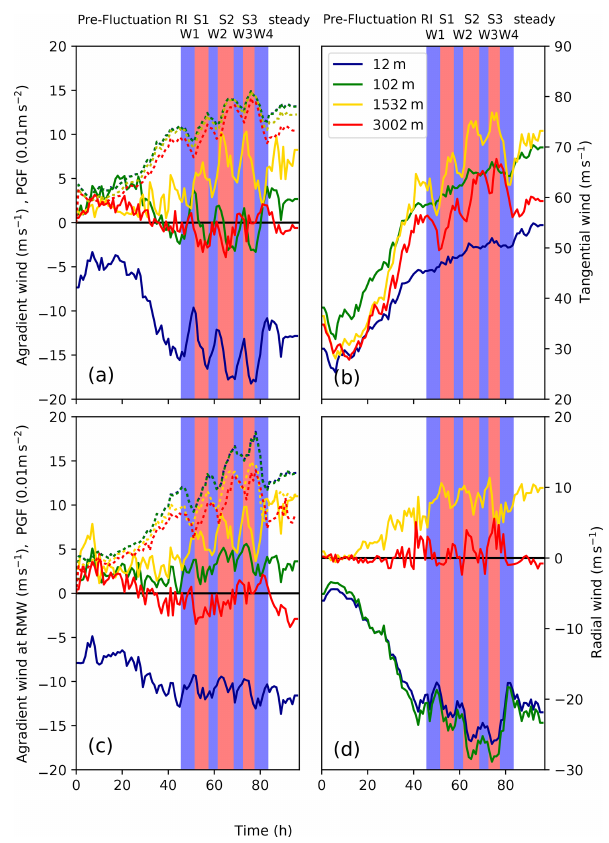
Figure 14. (a, c) shows azimuthally averaged agradient wind as a function of time (ms − 1 ) for (a) a radius of 35km and (c) at the height dependent RMW. Panels (b, d) show, for the 35km radius, the azimuthally averaged (b) tangential and (d) radial winds (ms − 1 ). The height of the lines are 12m (blue), 102m (green), 1902m (orange), and 3002m (red). Panels (a) and (c) also show the pressure gradient force (0.01ms − 2 , dashed lines) at se- lected levels. The RMW refers to the radius of maximum az- imuthally averaged tangential wind at each specified